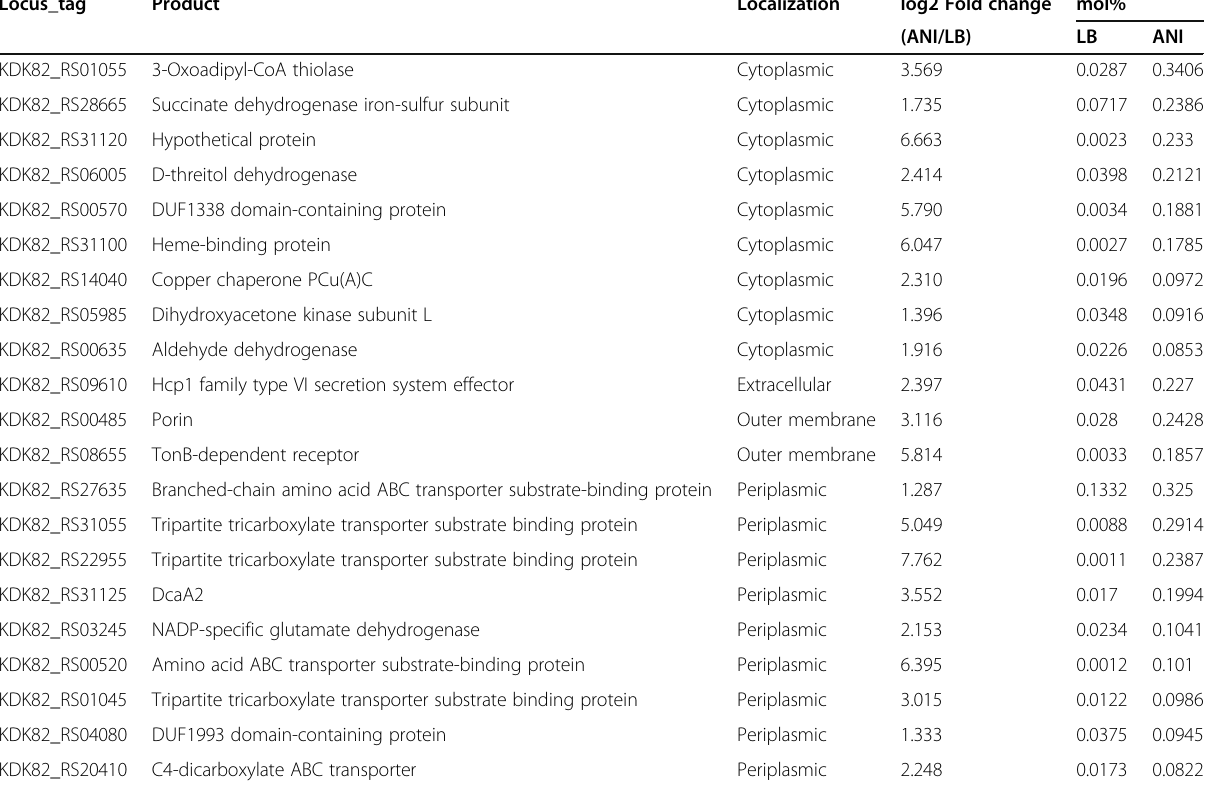
Table 4 Upregulated abundant proteins in aniline culture condition except aniline degradation pathway Locus_tag